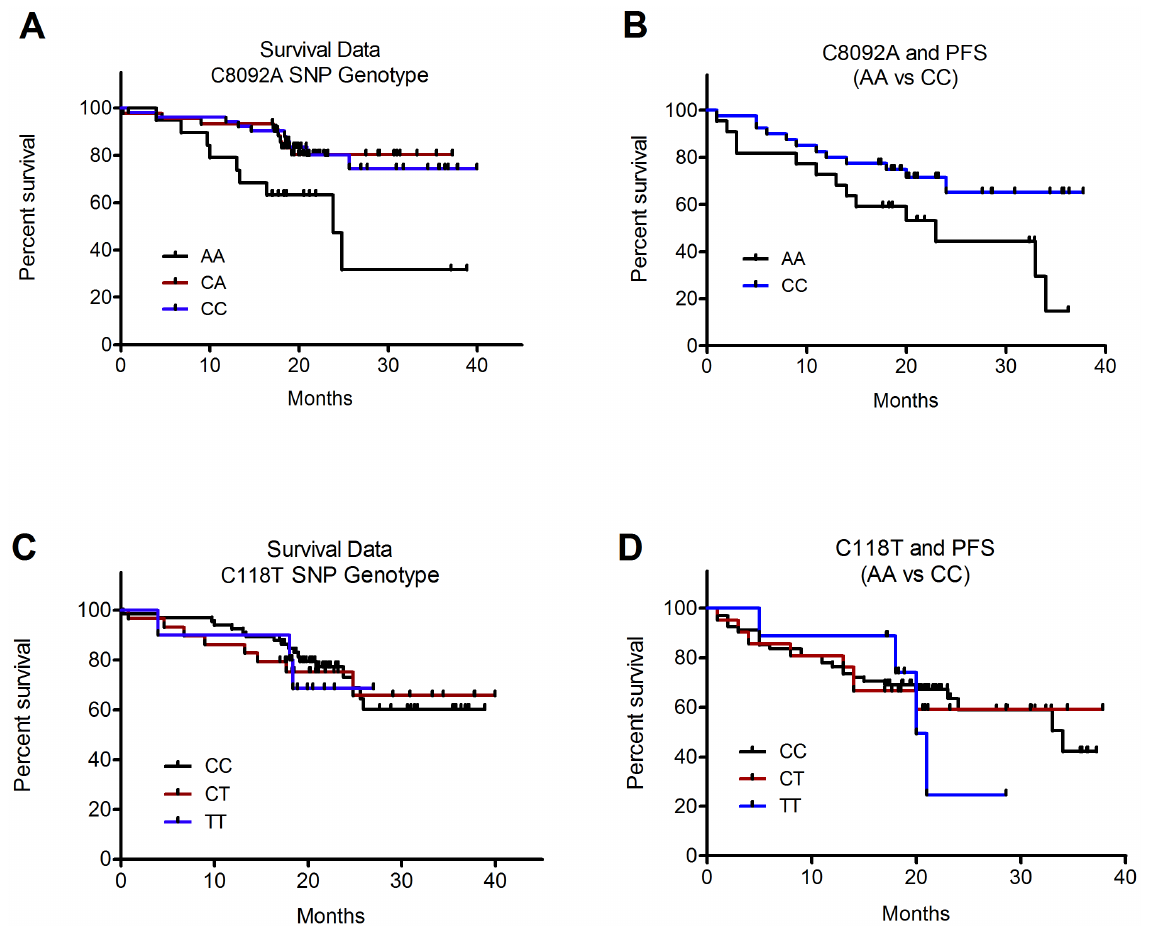
Figure 6. Association of ERCC1 polymorphism allelic variation on patient survival. A) ERCC1 polymorphism C8092A was significantly associated with overall patient survival (p=0.01). Presence of the mutant allele, especially for the homozygous patients for this allele (AA), was associated with decreased overall and progression-free survival (PFS) compared to homozygous wild-type patients (CC) (p=0.007 & 0.04, respectively). No significant relationship between polymorphism genotype and C) overall patient survival for C118T (p=0.78) or D) PFS was observed ( P =0.93).